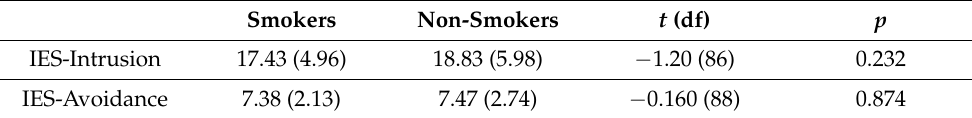
Table 2. Differences among groups in the impact of traumatic